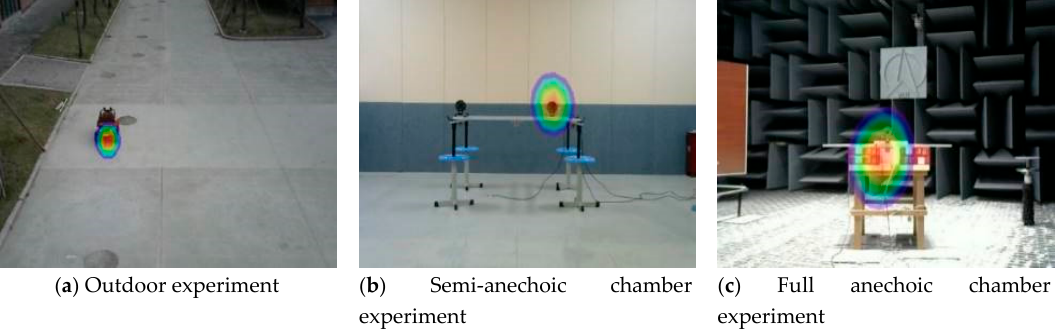
Figure 8. Sound phase image in the data set.